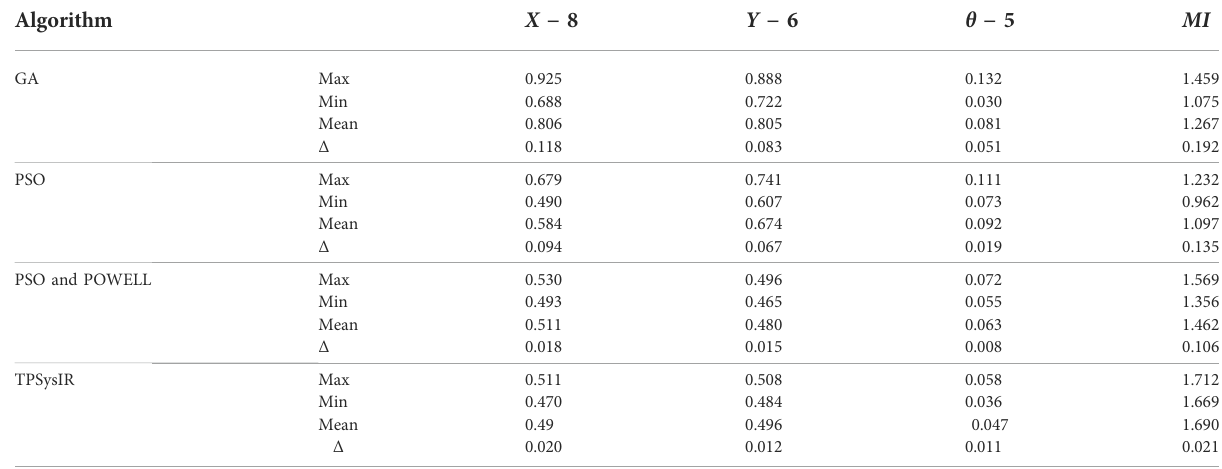
TABLE 1 Without scaling